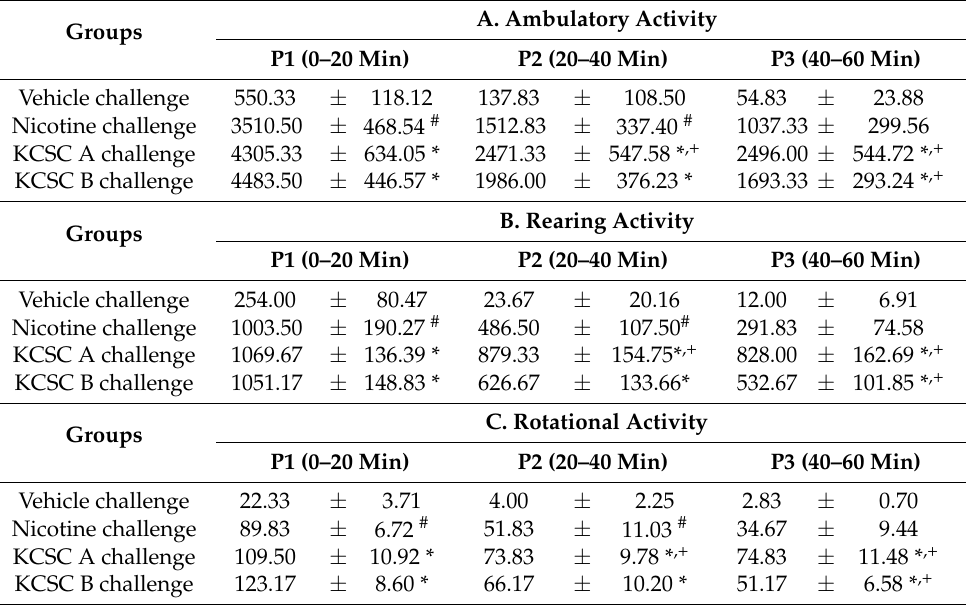
Table 3. Accumulative changes in ambulatory, rearing, and rotational activities at P1, P2, and P3 after challenge administration of vehicle, nicotine, KCSC A, and KCSC